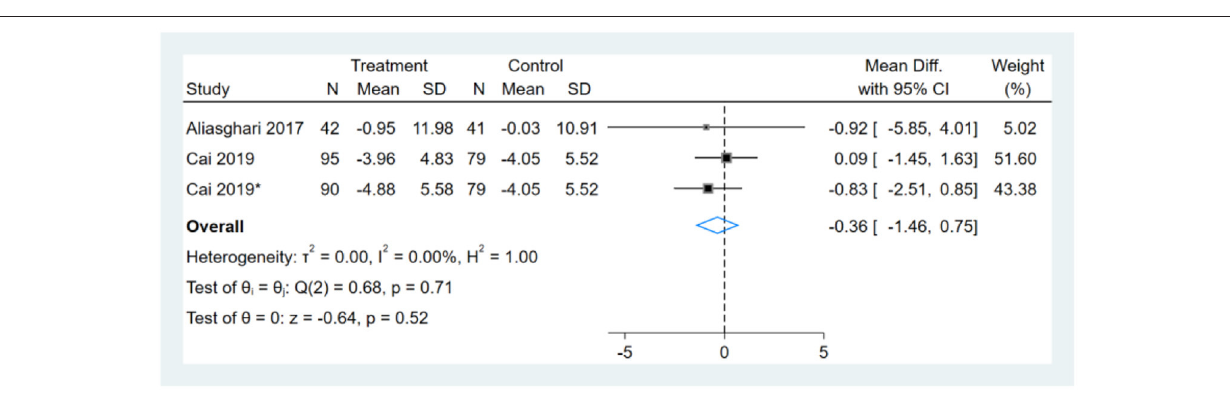
FIGURE 4 | Forest plot analysis showing waist circumference (WC) changes. *This study has two fasting intervention groups.